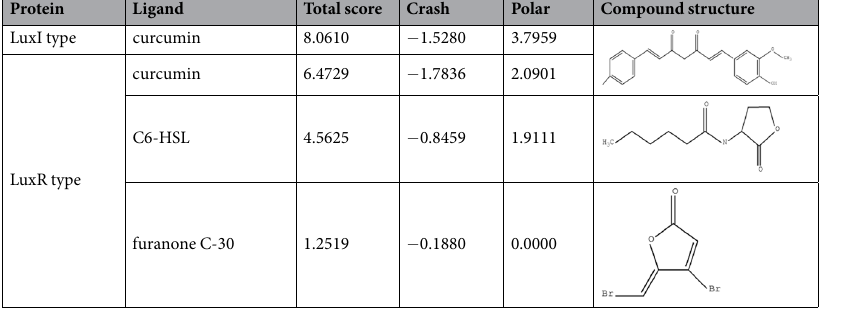
Table 4. Docking results of LuxI and LuxR type proteins of A. sobria with curcumin, C6-HSL and furanone